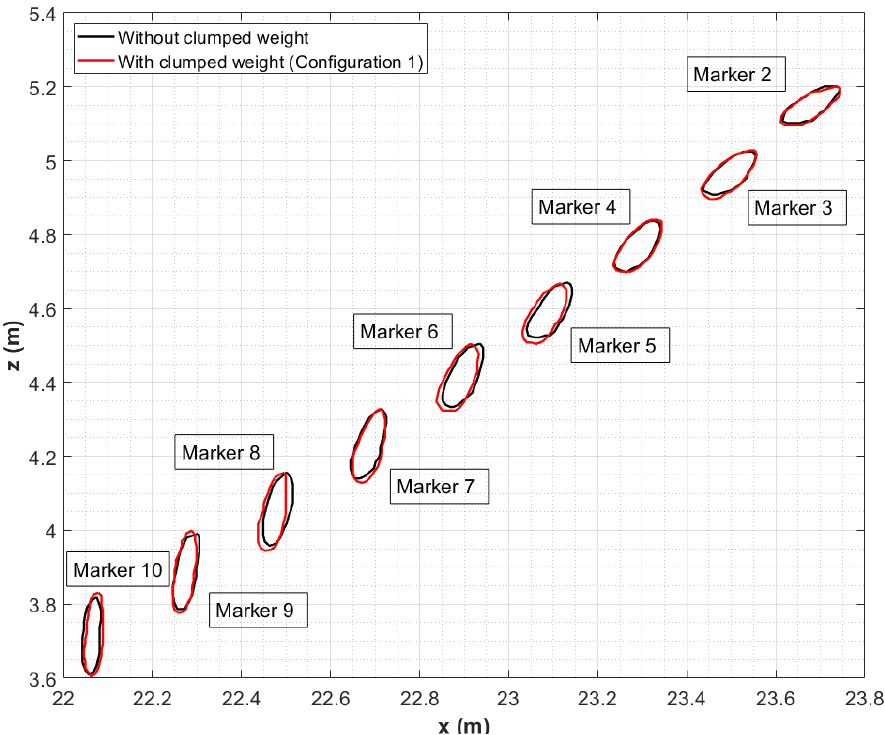
Figure 18. Trajectories of the tracked points of the mooring line for a top-end motion of an Amplitude of 0.175 m and periods 3.5 s. Markers 2 to 10 are indicated in the figure.